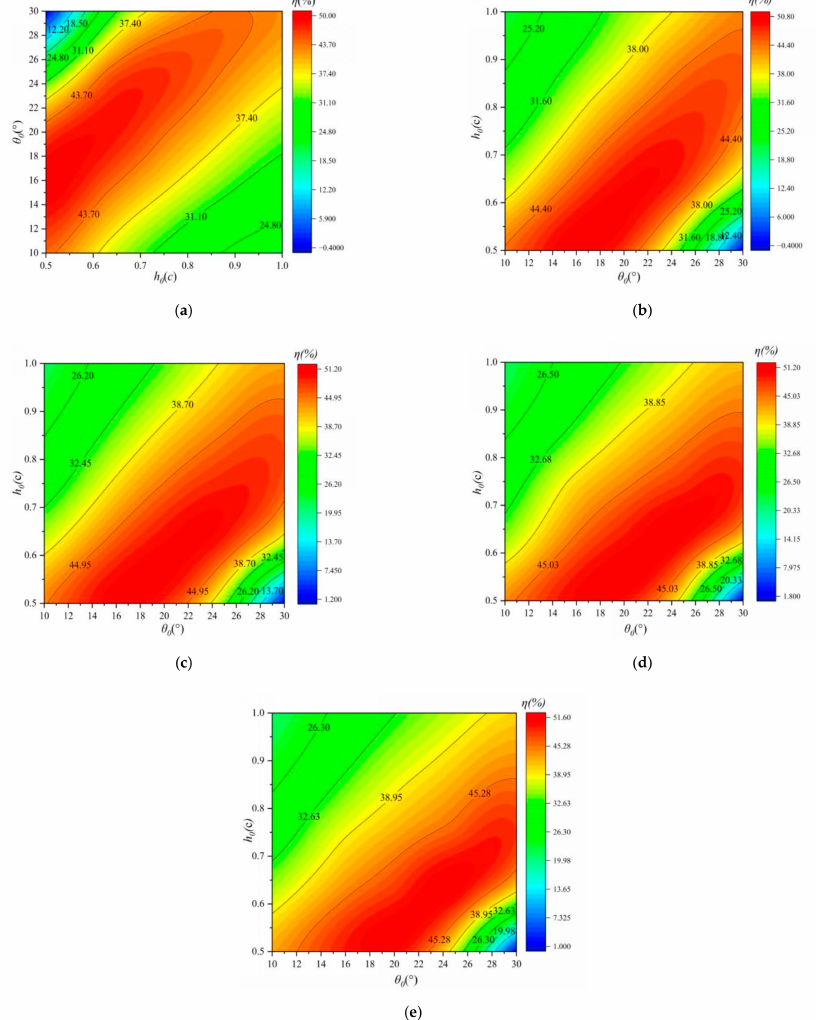
Figure 11. Variation of average propulsion efficiency with pitch amplitude under different heave motion amplitudes and phase differences ( a ) ϕ = 60 ◦ ( b ) ϕ = 75 ◦ ( c ) ϕ = 90 ◦ ( d ) ϕ = 105 ◦ ( e ) ϕ = 120 ◦